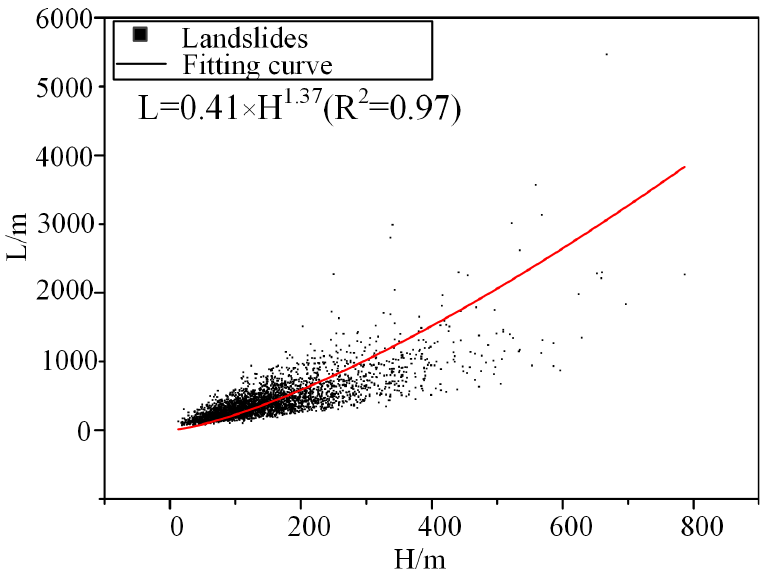
Figure 6. H-L relationship of